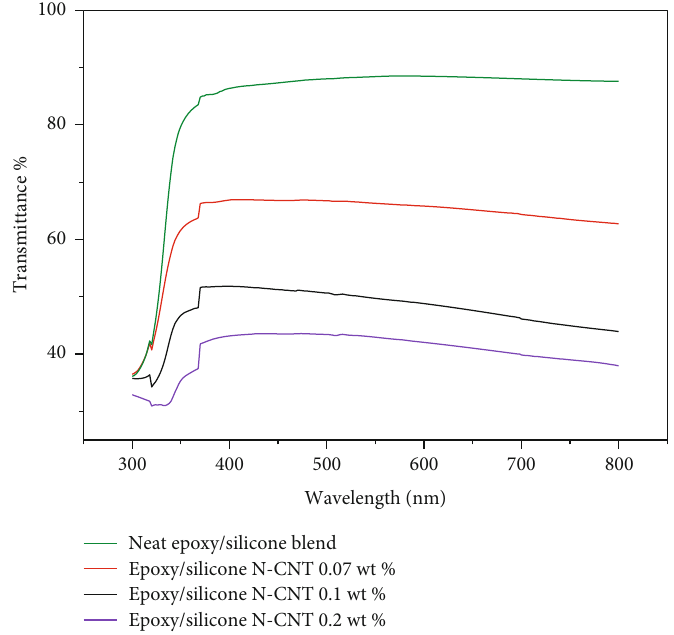
Figure 1: Curves of epoxy/silicone fi lm transmission as a function of wavelength for di ff erent N-CNT loading